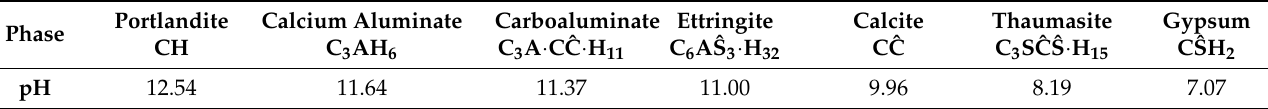
Table 1. Calculated pH of water in equilibrium with the solid phase, at 20 ◦ C